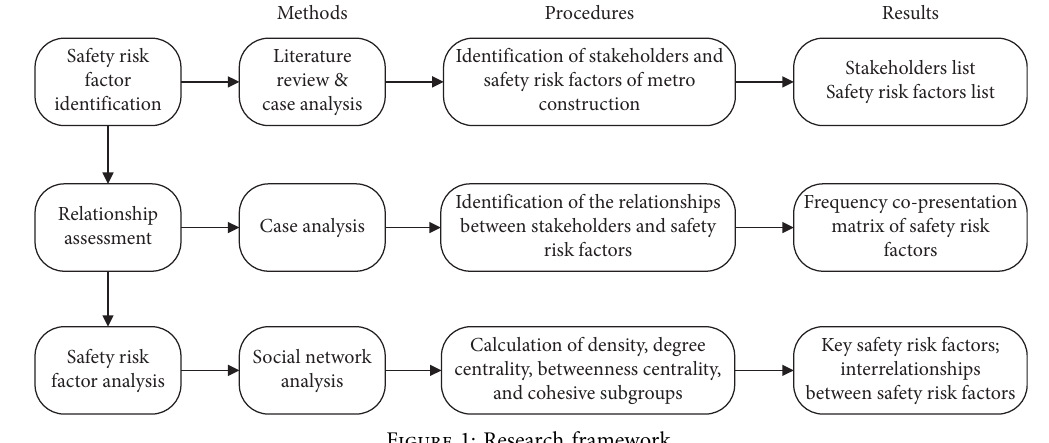
Figure 1: Research